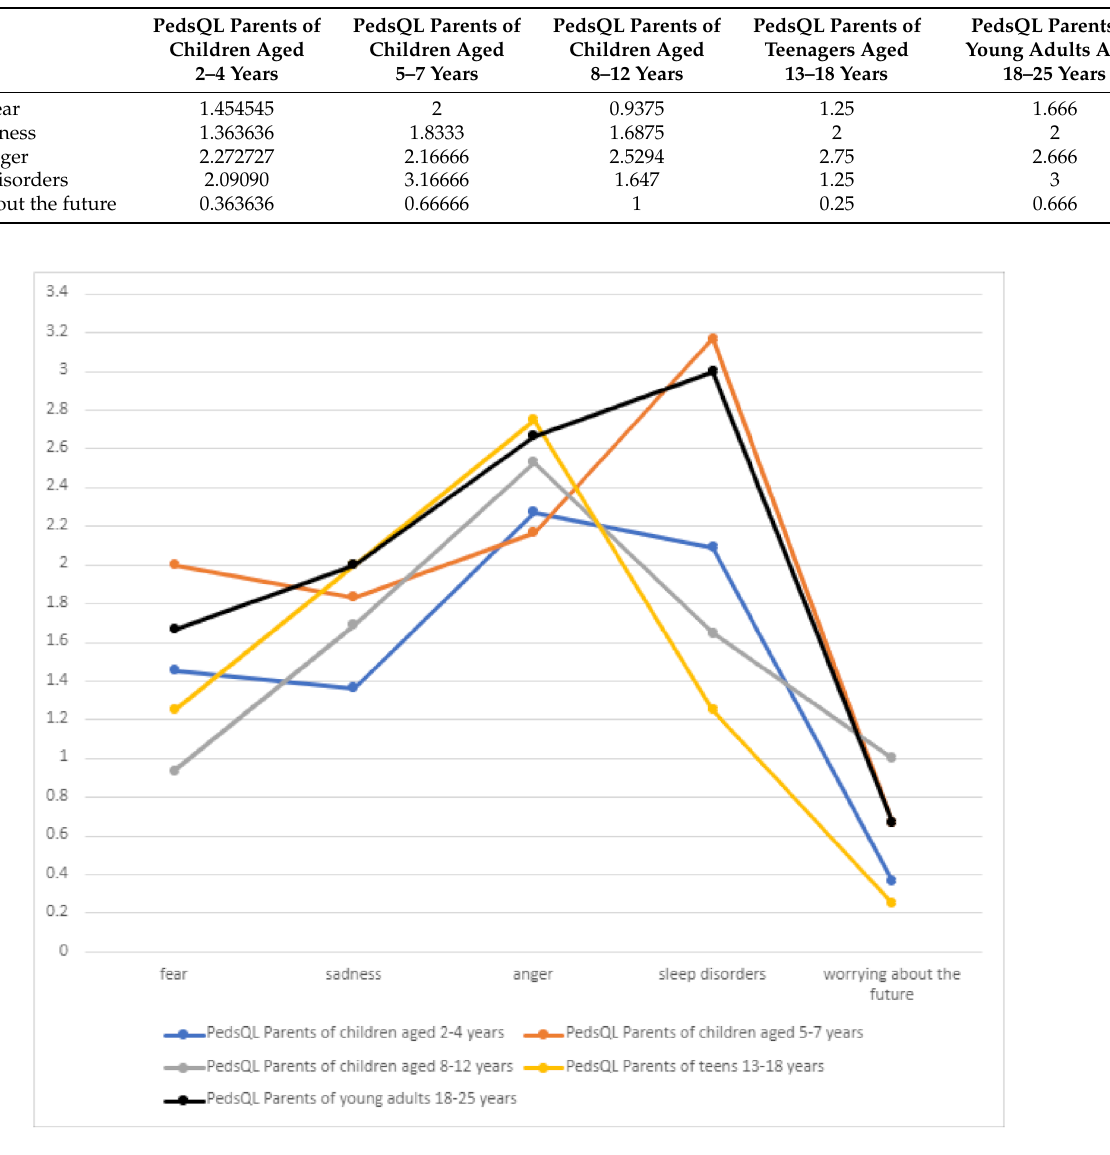
Figure 12. Emotional functioning of children with Dravet